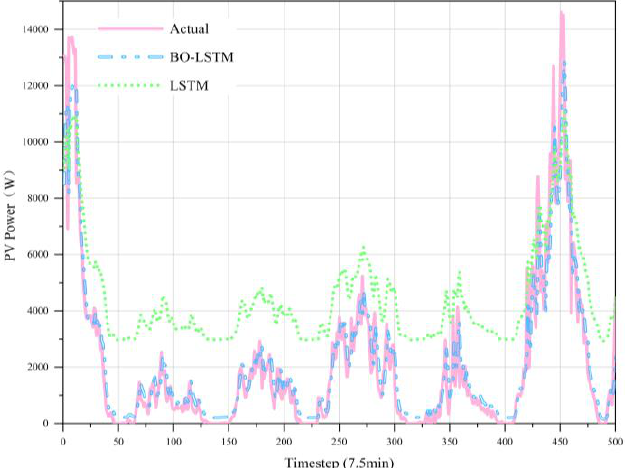
Figure 6. Forecast results of PV power in dataset 1.